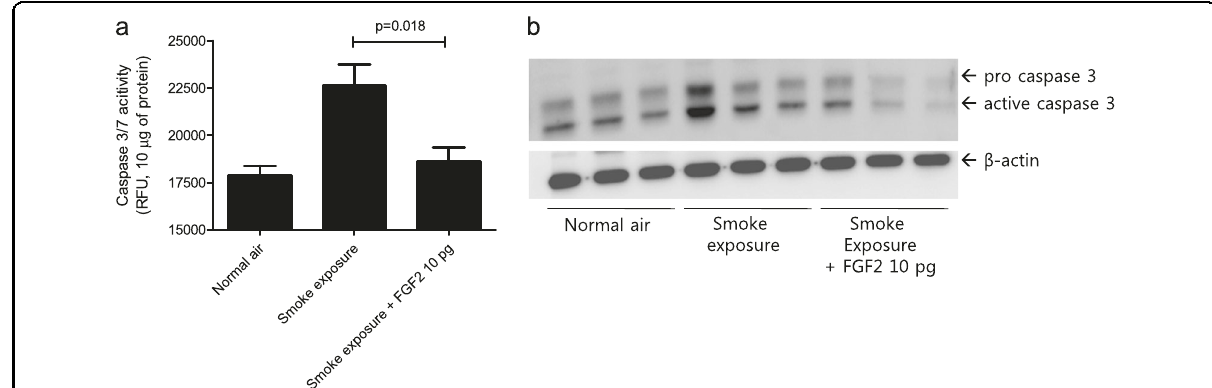
Fig. 4 Lung resident cell apoptosis in response to smoke was protected against by FGF-2 and dependent on caspase-3/7 signaling. a , b The mice were exposed to cigarette smoke for 4 days, and 10 pg of FGF-2 was intranasally administered within 1 h after smoke exposure. Mice were killed 18 h after the fi nal smoke exposure. a Caspase-3/7 activity using 10 μ g of lung lysate ( n = 9 per group). P -values were determined by the